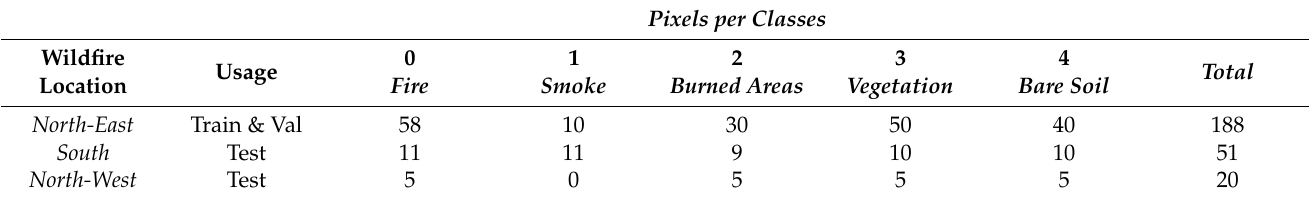
Table 5. Number of labelled reference pixels in Australia used for training and testing the CNN [52]. Pixels per